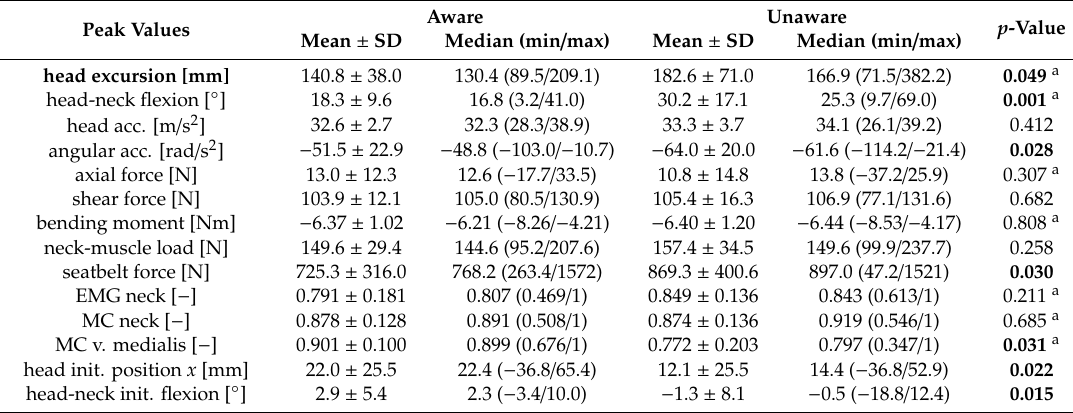
Table 1. Peak values for the head-neck motion, neck loads, normalised EMG, and normalised MC sensor signals in the aware and unaware trials: mean ± standard deviation (SD), median (min / max), and corresponding p -values for pairwise comparisons between the aware and unaware conditions.